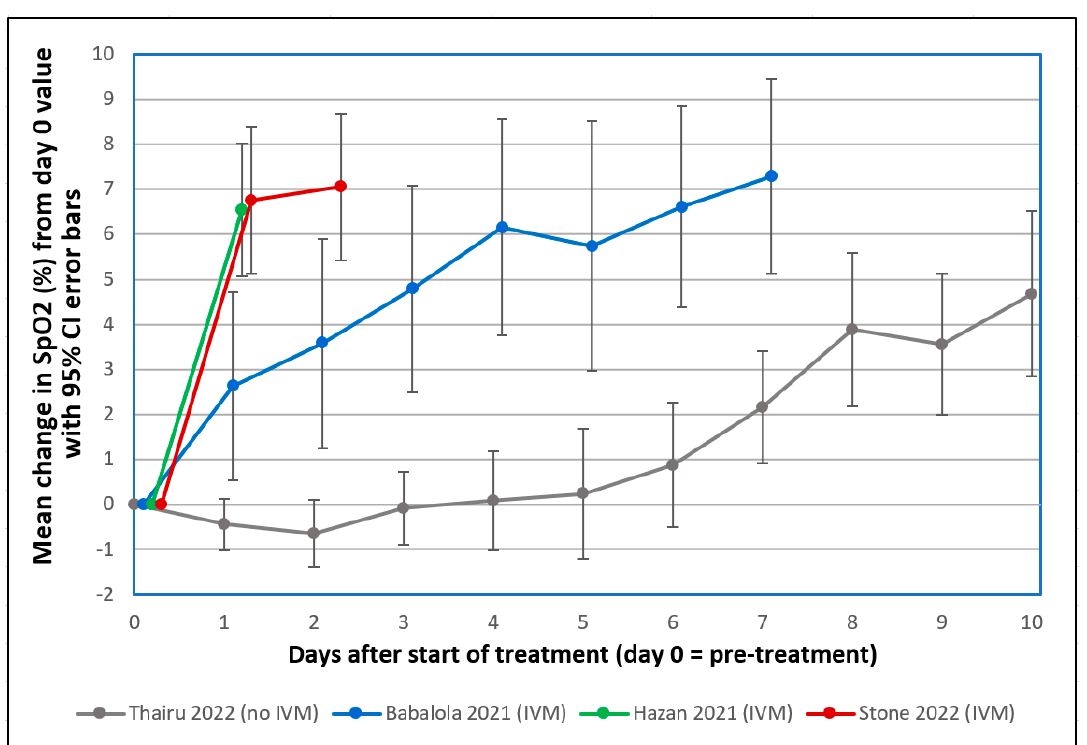
Figure 6. Mean changes in oxygen saturation (SpO2) for severe COVID-19 patients following treatments including and excluding IVM. Patients tracked from each regimen had SpO2 values all recorded on room air and had pre-treatment (Day 0) values ≤ 93%. The y axis value at day n is the mean of changes in SpO2 values from Day 0 to day n, with error bars designating 95% confidence intervals. Thairu et al., 2022 ( ● , [38,44] ), tracked SpO2 at Days 0–10 for 26 COVID patients, pre- treatment SpO2 of 81–91%, median age 45, treated with varying combinations of lopinavir/ritonavir (Alluvia), remdesivir, azithromycin, and enoxaparin plus zinc sulfate and vitamin C. Babalola et al., 2021 ( ● , [39,44] ), tracked SpO2 at Days 0–7 (sporadic values for Days 8–10 not shown) for 19 COVID patients, pre-treatment SpO2 of 76–93%, median age 33, treated with IVM, zinc, and vitamin C, some also given azithromycin and hydroxychloroquine. Deidentified patient data for these two regimens are as communicated by Femi Babalola to the authors on March 21, 2022. Hazan et al., 2021 ( ● , [45] ), tracked SpO2 at Days 0–1 for 19 COVID patients, pre-treatment SpO2 of 73–90%, media age 63, treated with IVM, doxycycline, and zinc. Stone et al., 2022 ( ● , this study), treated 34 COVID patients,